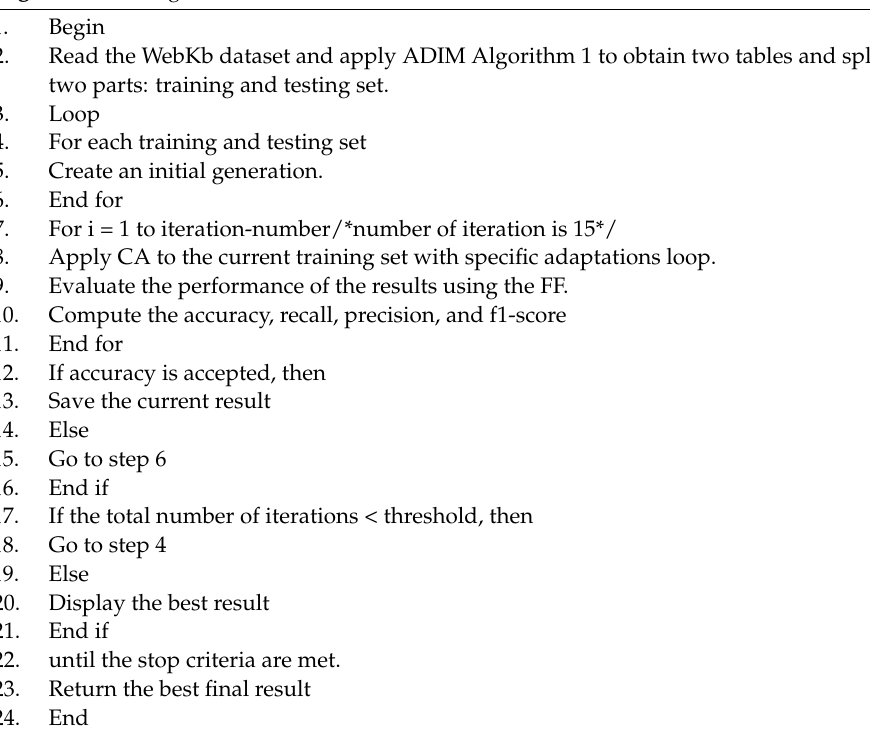
Algorithm 5: Integration between MGA, and